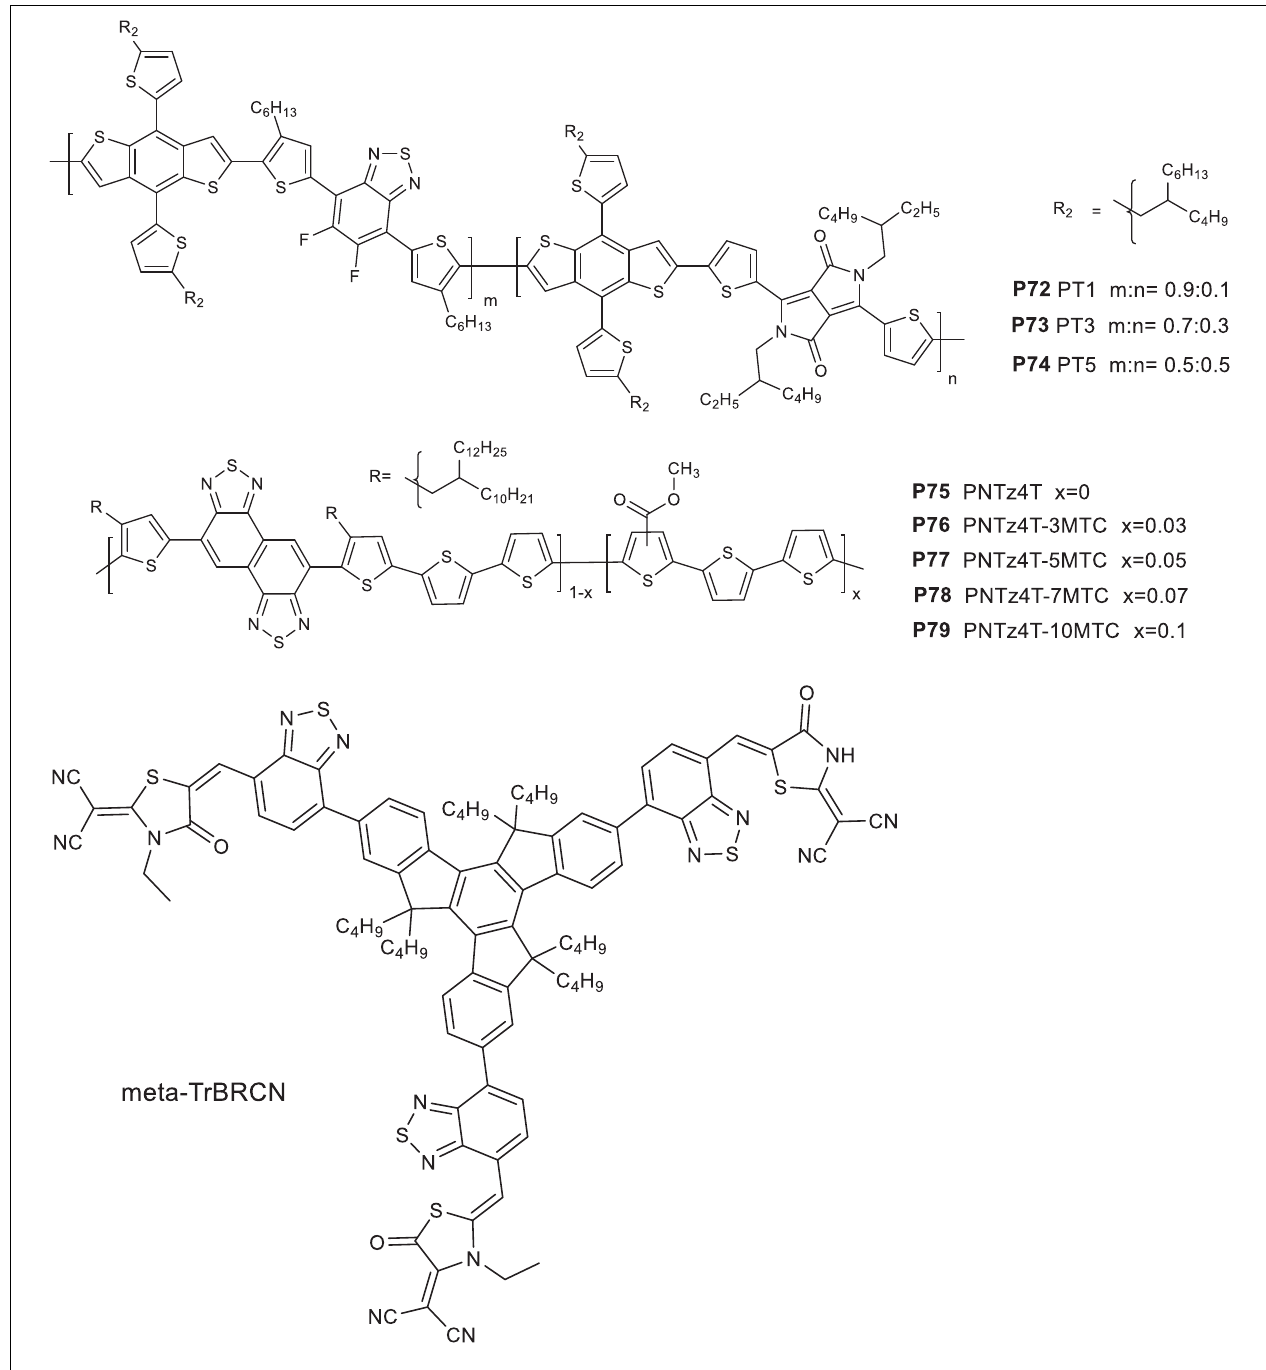
FIGURE 7 | Donor polymers based on benzothiadiazole acceptor as one component ( P56 – P79 ) and